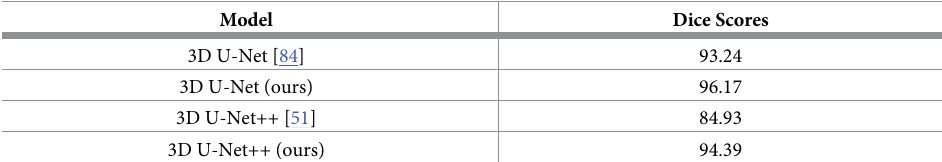
Table 10. Comparison of whole tumor segmentation with BRATS 2021.